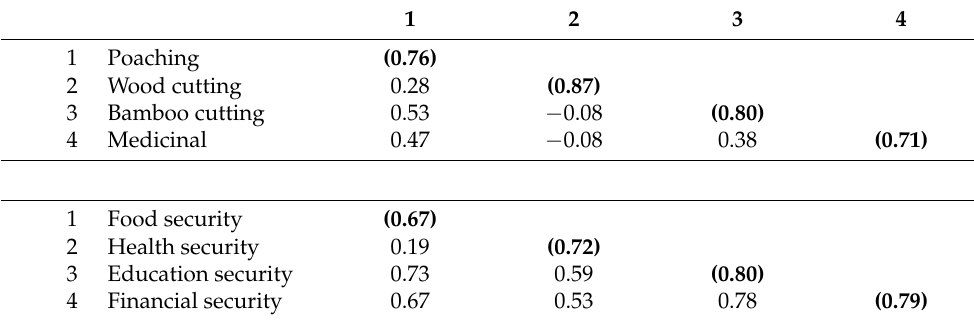
Table 3. Factor Correlations and Testing for Discriminant